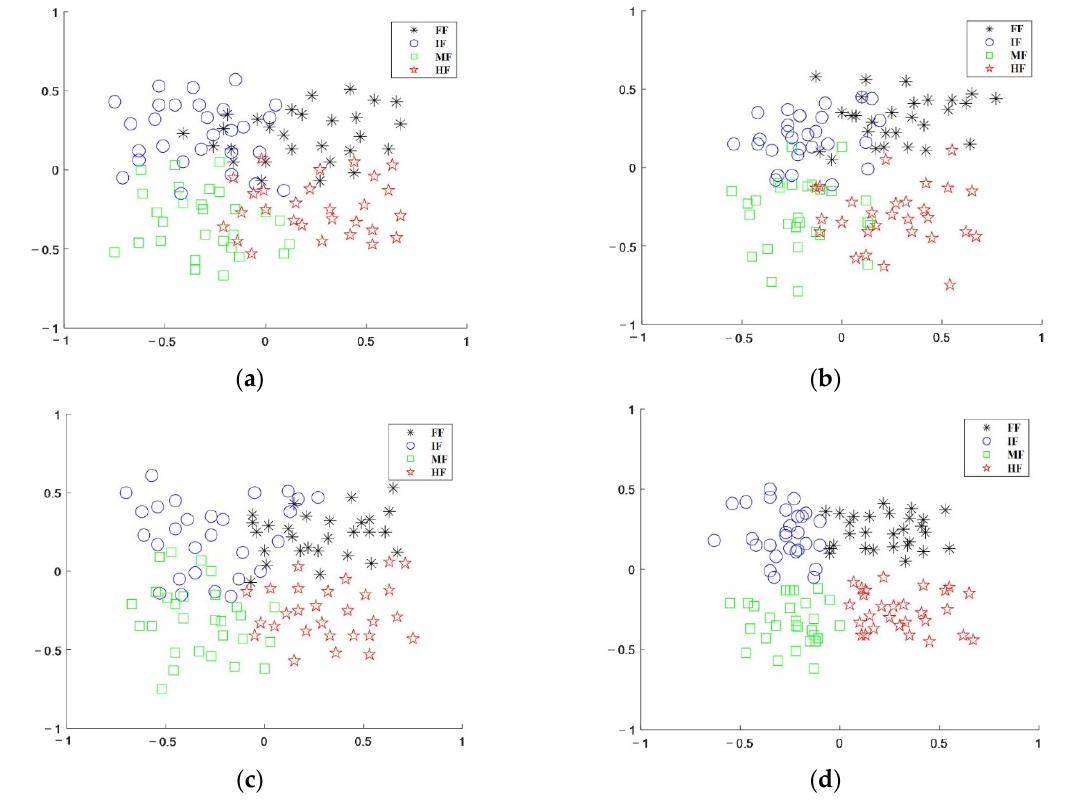
Figure 8. The projection effect of test samples under different data feature samples: ( a ) based on dimensionless time domain characteristics, ( b ) based on EMD decomposition energy, ( c ) based on VMD decomposition energy, and ( d ) based on multi-information fusion.